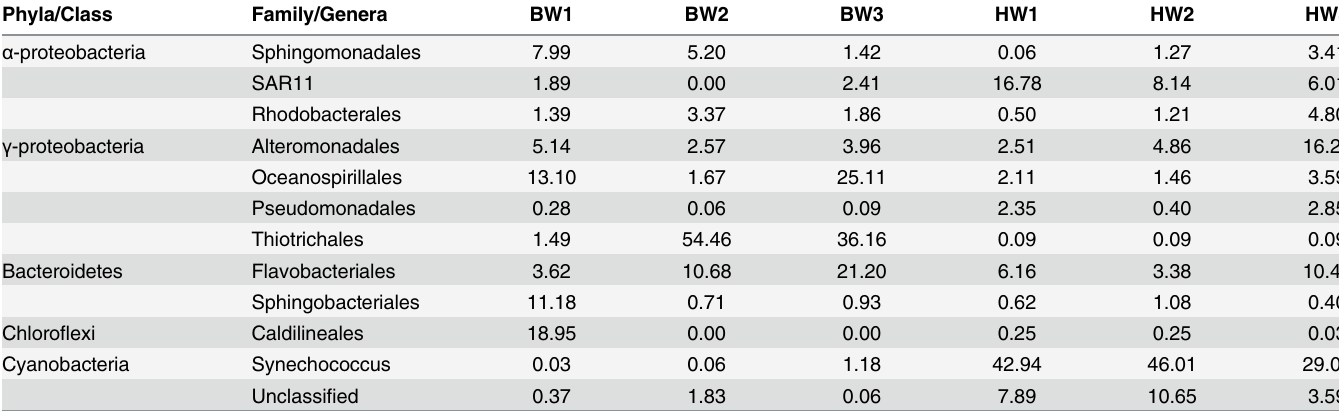
Family/genera representing > 1% of total sequences assigned were selected for comparison.